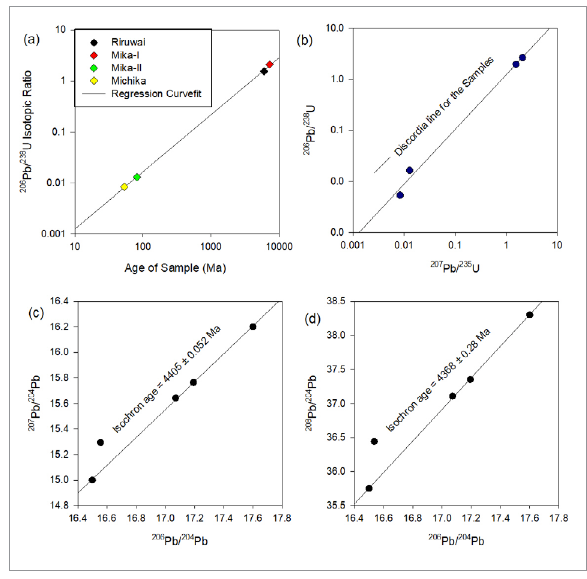
Figure 4: (a) A regression curve fit for the correlation of the 206 Pb/ 238 U isotopic ratio with determined age of the natural uranium samples. (b) U-Pb discordia graph for the parent-daughter isotopic ratios ( 206 Pb/ 238 U and 207 Pb/ 235 U) of the samples. (c) Pb-Pb isochron diagram (for the 207 Pb/ 204 Pb and 206 Pb/ 204 Pb isotopic ratios) defining an isochron of 4405±0.052 Ma for the four samples of natural uranium from northern Nigeria. (d) Pb-Pb isochron diagram (for the 208 Pb/ 204 Pb and 206 Pb/ 204 Pb isotopic ratios) defining an isochron of 4368±0.027 Ma for the four samples of natural uranium from northern